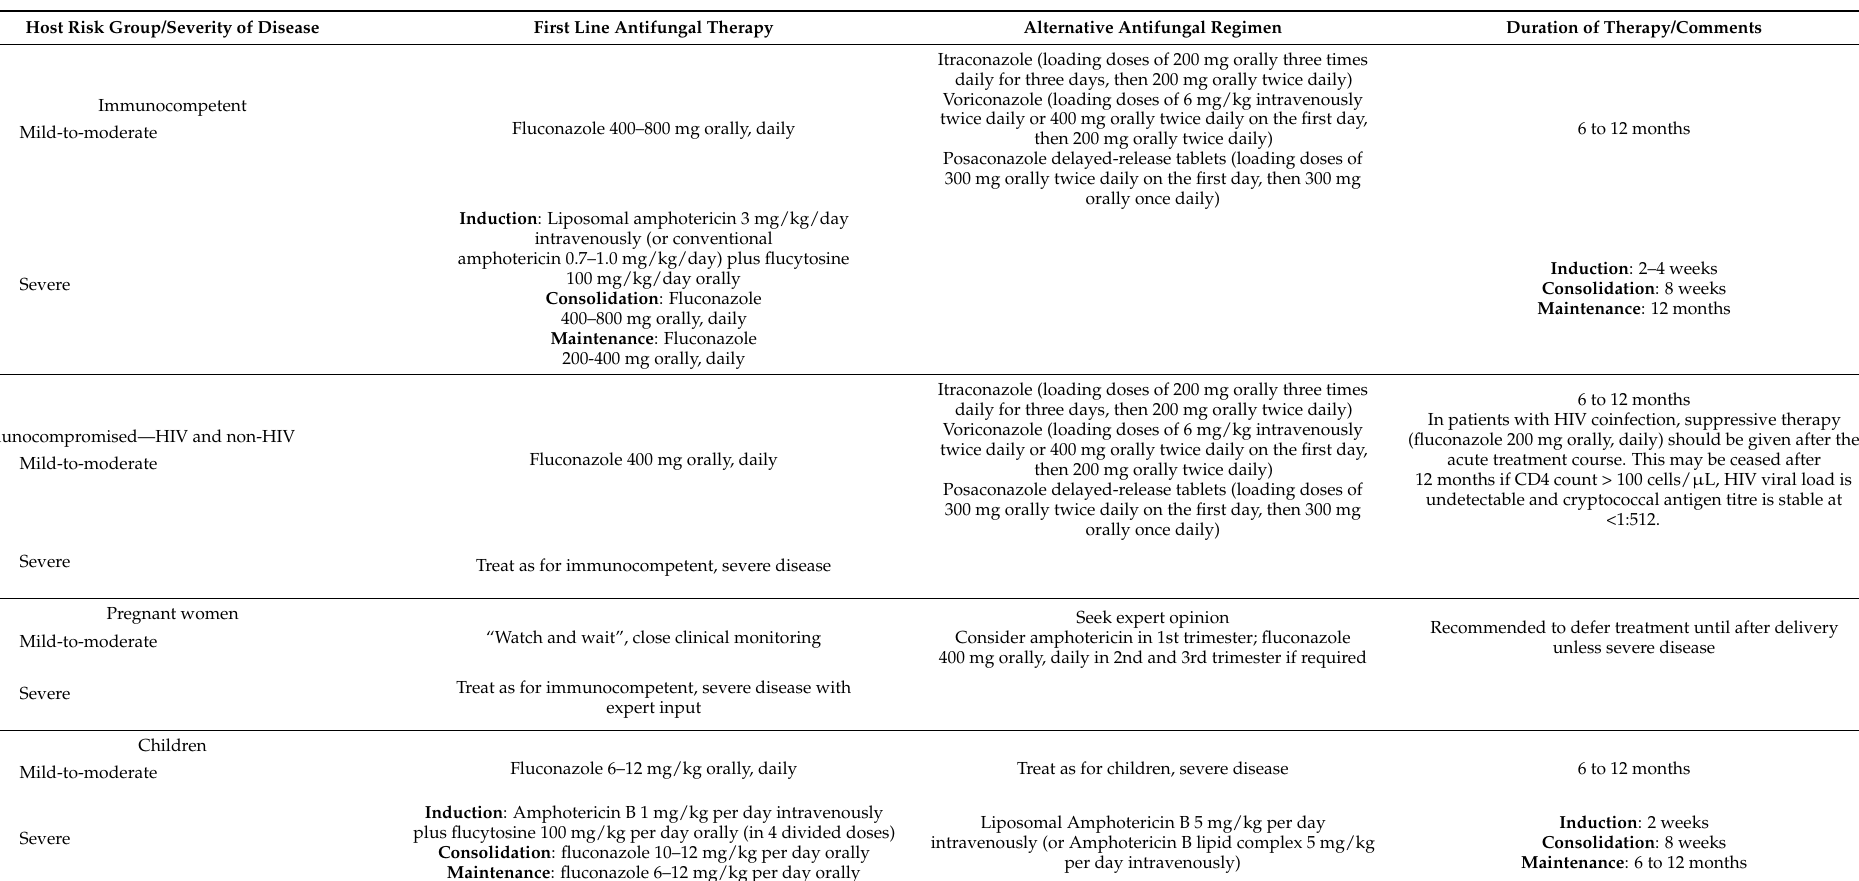
Table 2. Treatment and dosage guidance for management of Cryptococcus neoformans and Cryptococcus gattii pulmonary infections. Modified from the Infectious Diseases Society of America (IDSA), American Society of Transplantation (AST), Australasian Antifungal Guidelines Steering Committee and the American Thoracic Society guidelines